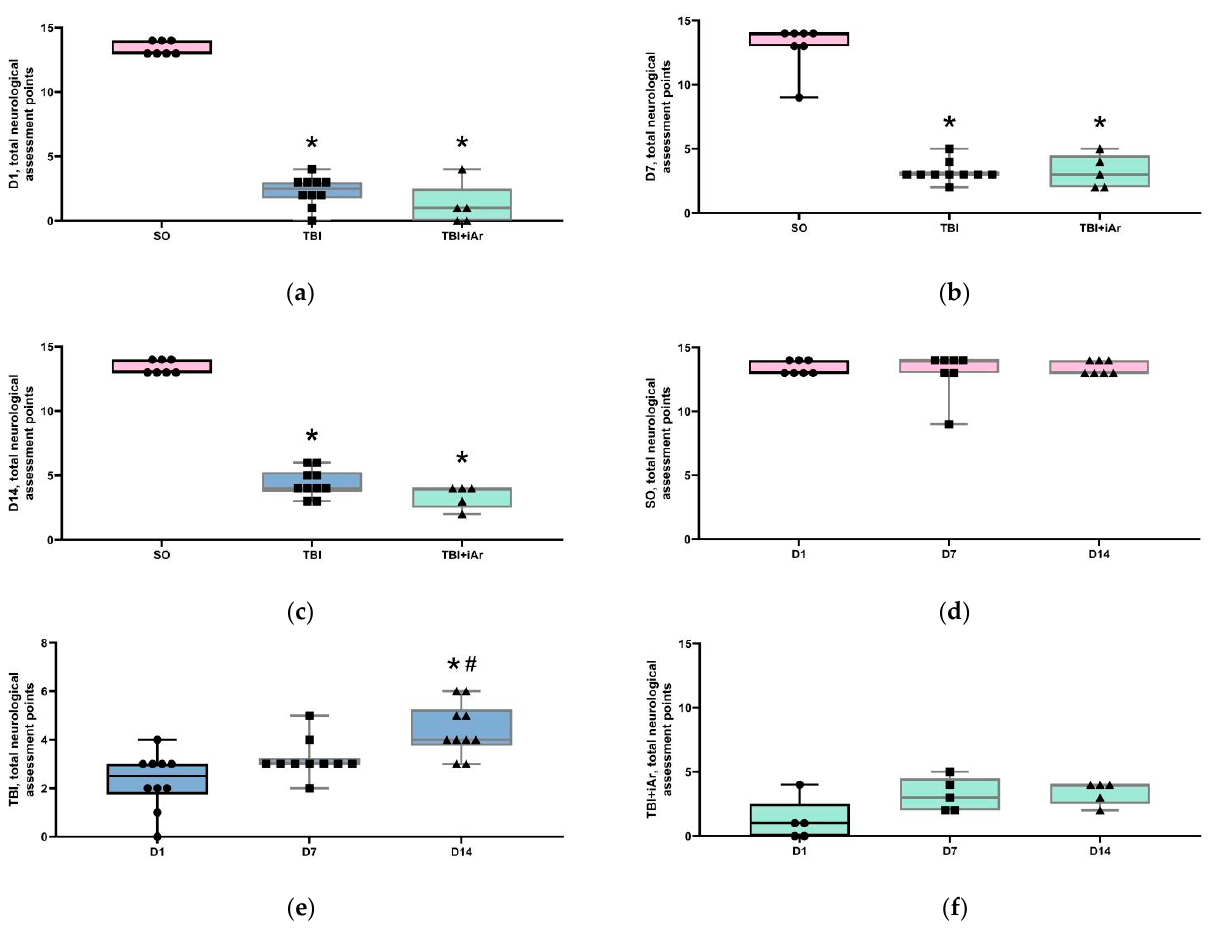
Figure 2. ( a ) LPT score 1 day after the simulation of TBI; ( b ) LPT score 7 days after the simulation of